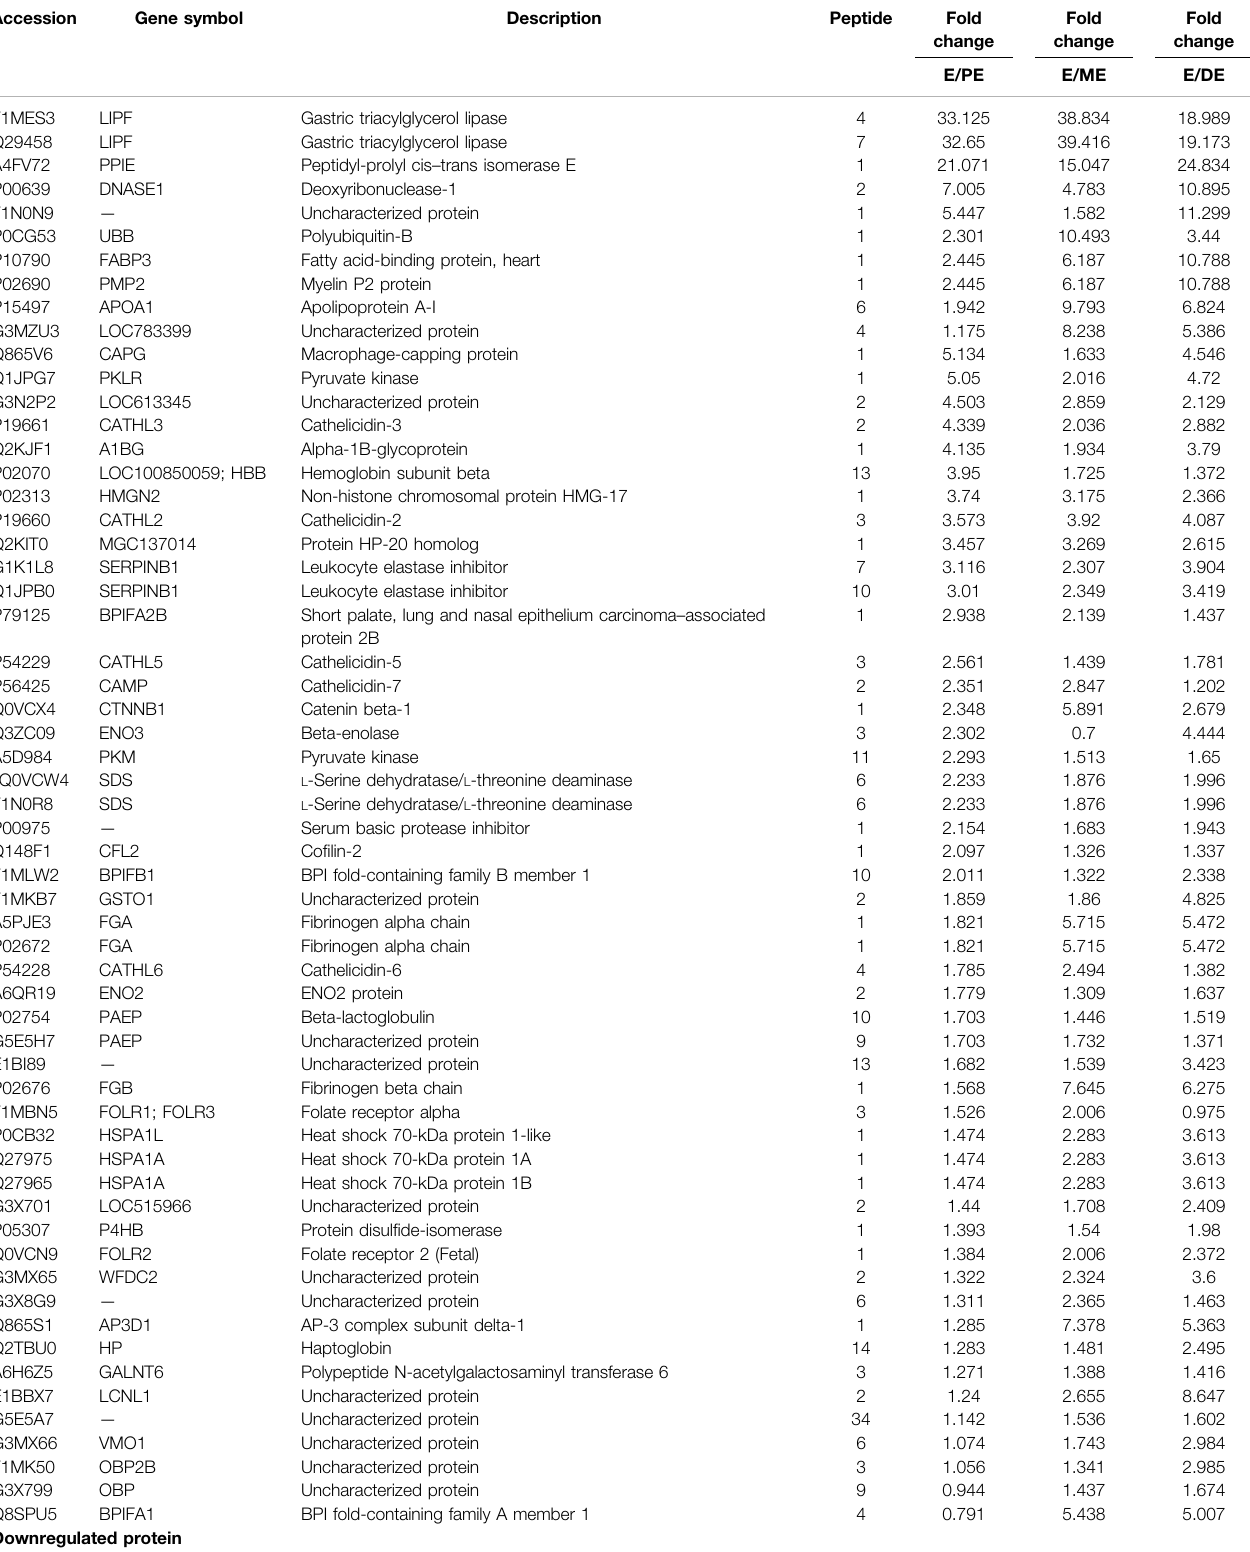
TABLE 3 | List of differentially expressed proteins (DEPs) during estrus (E) vs. proestrus (PE), metestrus (ME), and diestrus (DE) stages using LFQ-LC-MS/MS analysis.